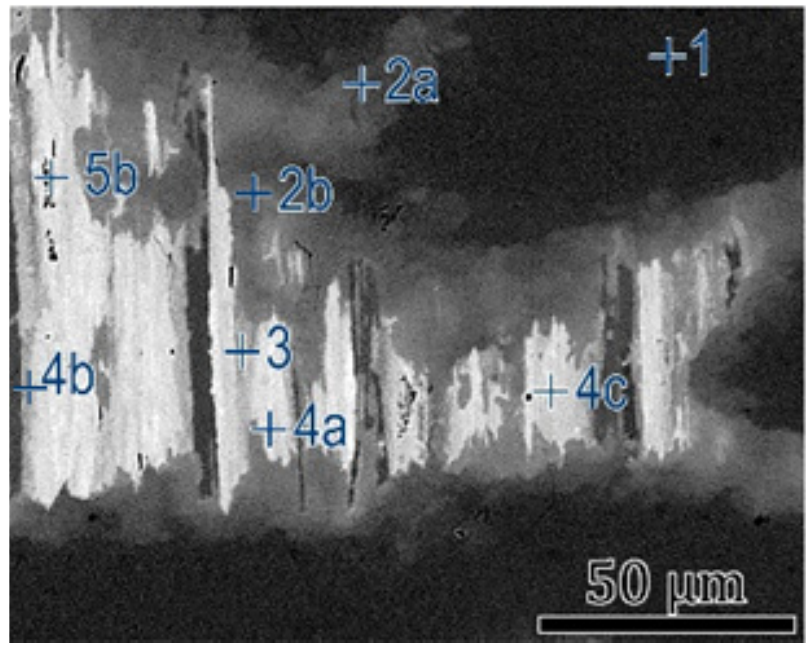
Figure 4. Microstructure (SEM images, back scattered electron mode) of the as-cast Sm 1-x Zr x (Co 0.702 Cu 0.088 Fe 0.210 ) z alloy sample with x = 0.13 and z = 6.4; EMA points are shown.